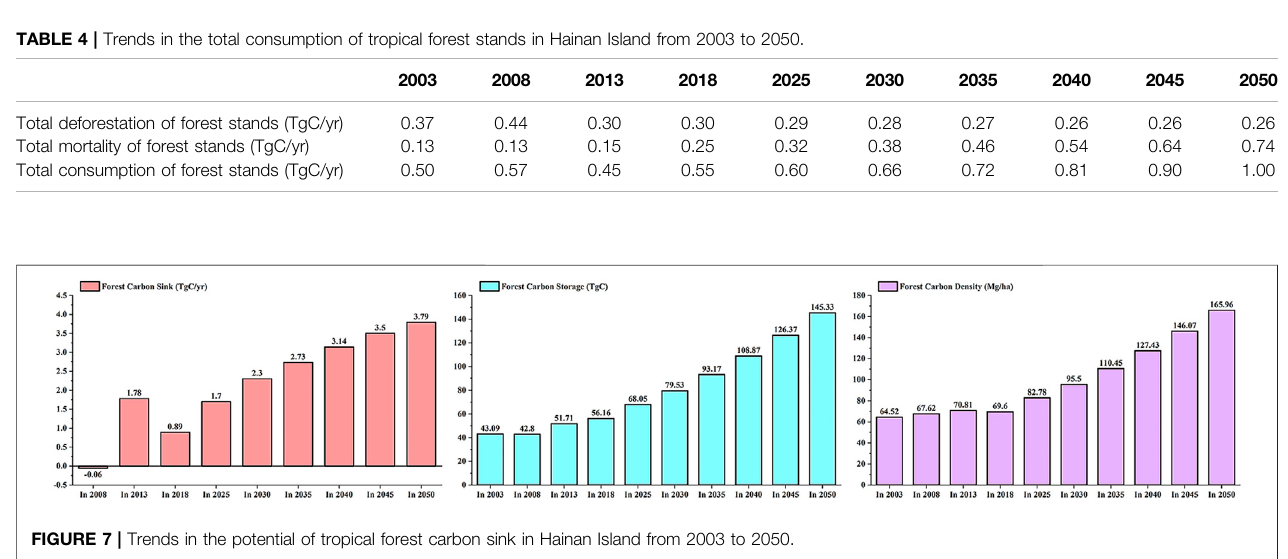
FIGURE 7 | Trends in the potential of tropical forest carbon sink in Hainan Island from 2003 to 2050.